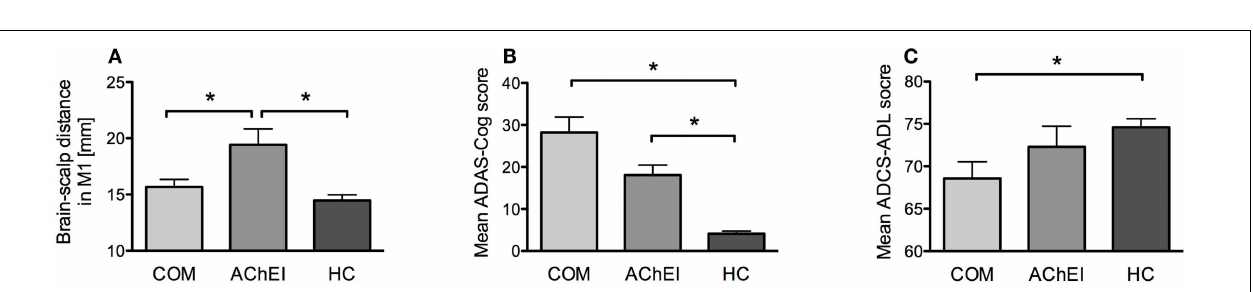
FIGURE 2 |TMS-driven measures of corticomotor reactivity and plasticity inAlzheimer’s patients treated with acetylcholinesterase inhibitors (AChEI) or a combination ofAChEI and memantine (COM), and a healthy age-matched control group (HC) . (A) Resting motor